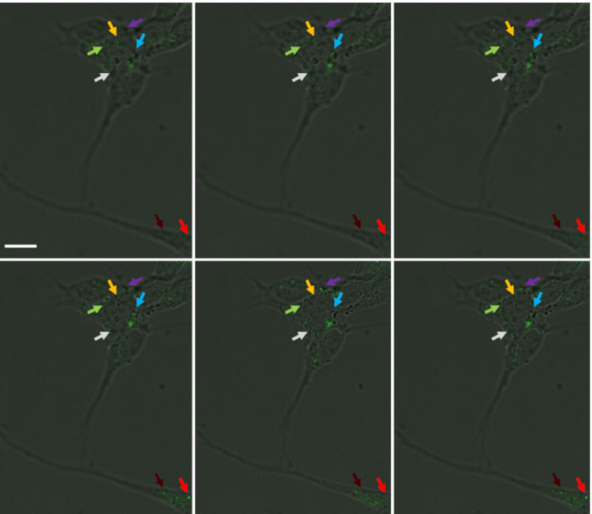
Figure 3. Confocal microscopy of the differentiated SH-SY5Y cells immunostained by UCNPs modified with Pep-1 and VDAC-1 antibody to target mitochondria. Z-stack serial imaging by a multiphoton microscope (Leica TCS SP8 MP) under excitation of 980 nm indicated the presence and accumulation of UCNPs in specific locations in both cell body and extensions. The same regions are marked with different arrow colors for better observation. Scale bar: 6 µ